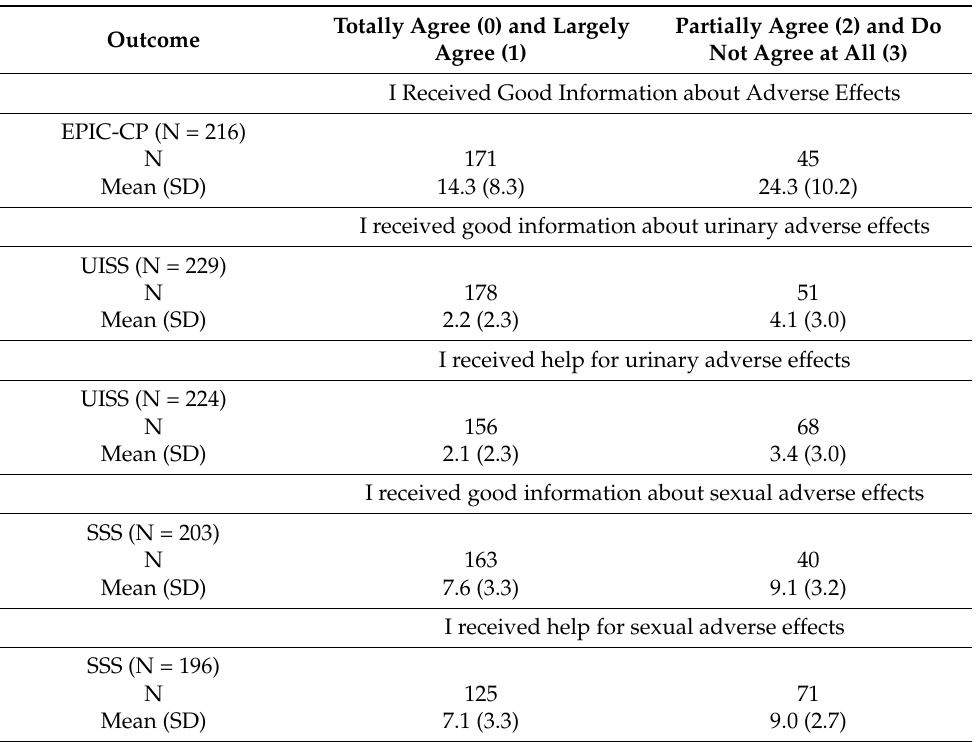
Table 2. Descriptive statistics of EPIC-CP total score, urinary incontinence symptom score (UISS) and sexual symptom score (SSS) stratified on PREM questions.